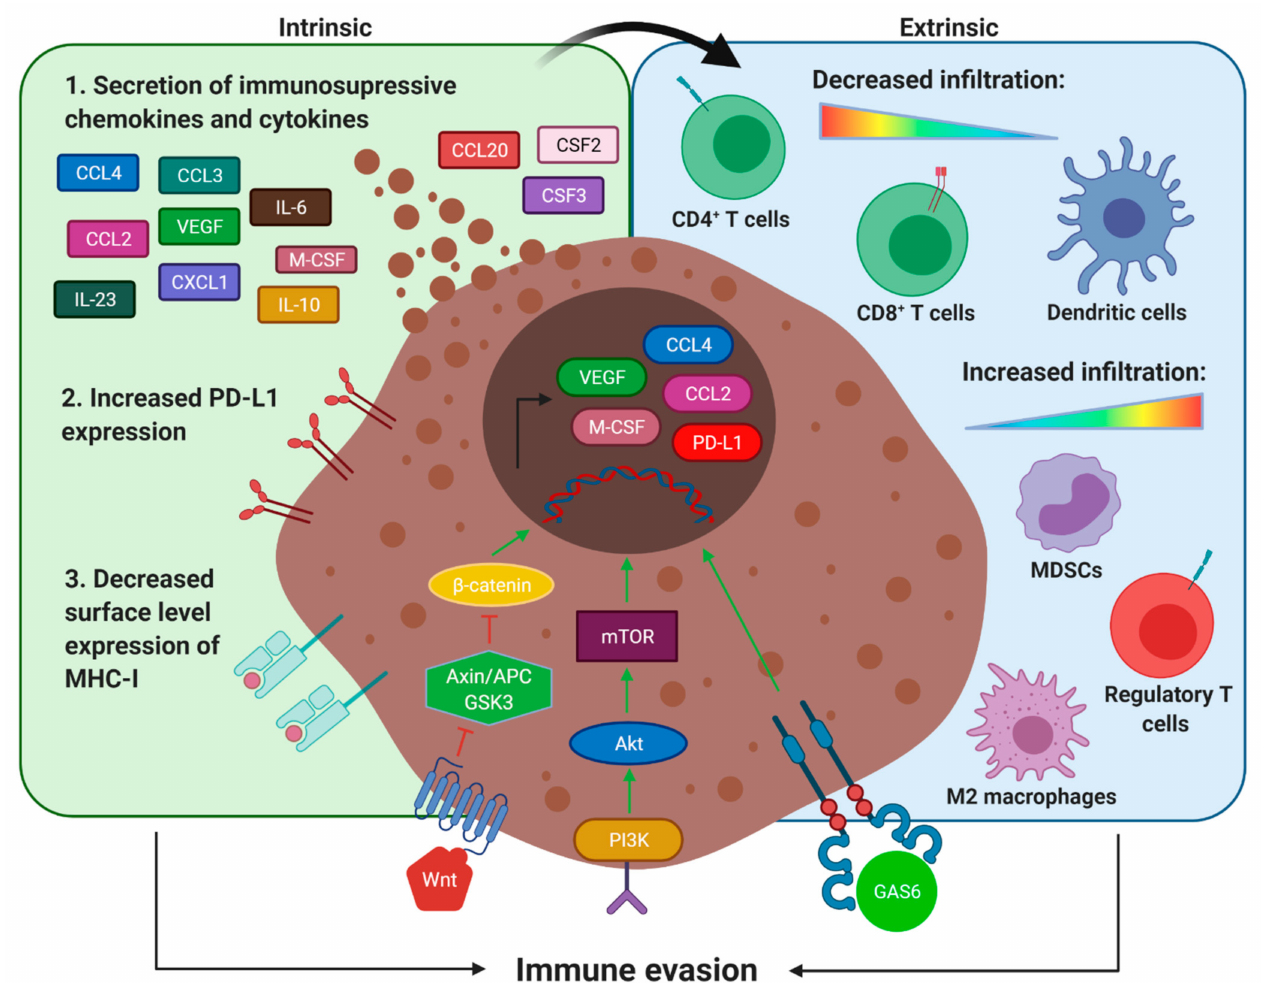
Figure 1. Graphical representation of the different pathways that have a proven role in ICB resistance in other tumor types and could contribute to ICB resistance in uLMS. Overactivation of the PI3K/mTOR, Wnt/ β -catenin, and AXL signaling pathways leads to a reduced expression of MHC-I molecules and increased expression of PD-L1 and immunosuppressive cytokines and chemokines. These cytokines and chemokines actively recruit immunosuppressive cell populations to the TME, while hindering the infiltration and activation of Teff cells and DCs. Created with